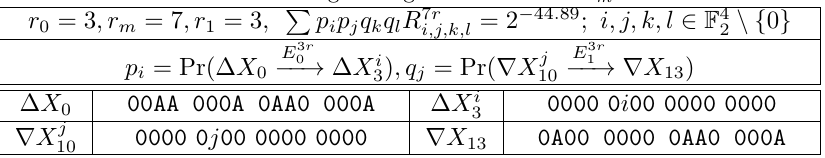
Table 14: The extended boomerang distinguisher based on E 7 r m for 13 rounds of CRAFT r 0 = 3 , r m = 7 , r 1 = 3 , P p i p j q k q l R 7 r